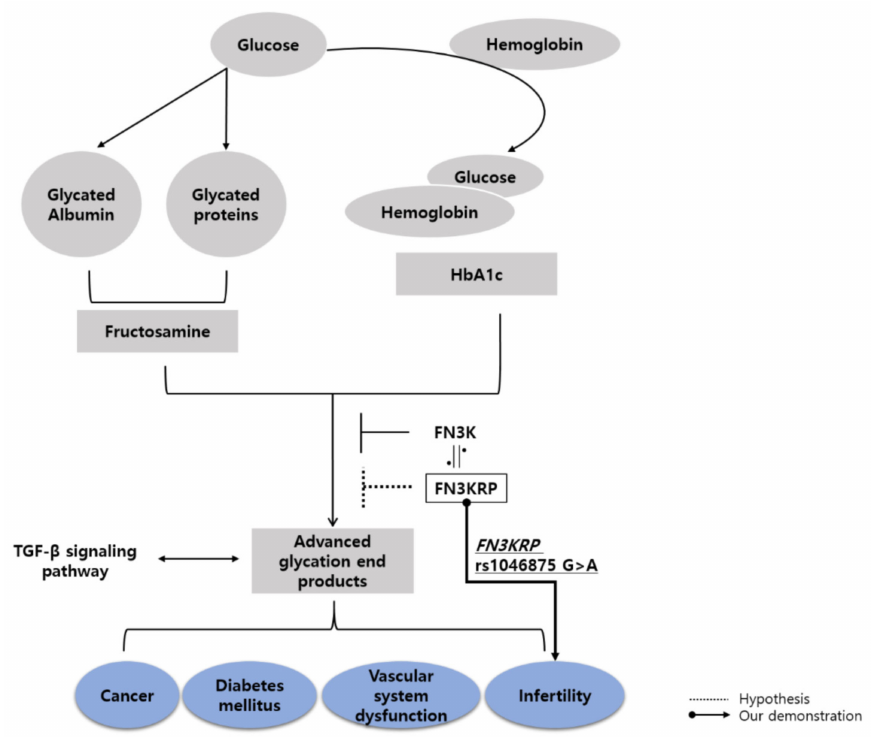
Figure 1. Overview of the formation and impact of AGEs. Proteins in the blood, such as albumin and hemoglobin, react with plasma glucose and generate glycated proteins including fructosamine and HbA1c, leading to the formation of AGEs through non-enzymatic glycation. The AGE formation process is restricted by FN3K , which is similar in structure to FN3KRP. The high level of AGEs can induce multiple diseases such as cancer, diabetes mellitus, vascular system dysfunction and infertility and interacts with the TGF- β signaling pathway. In our study, we indicated the association between FN3KRP rs1046875 G>A and RPL. Therefore, we propose that FN3KRP may inhibit the formation of AGEs and affect the RPL, infertility